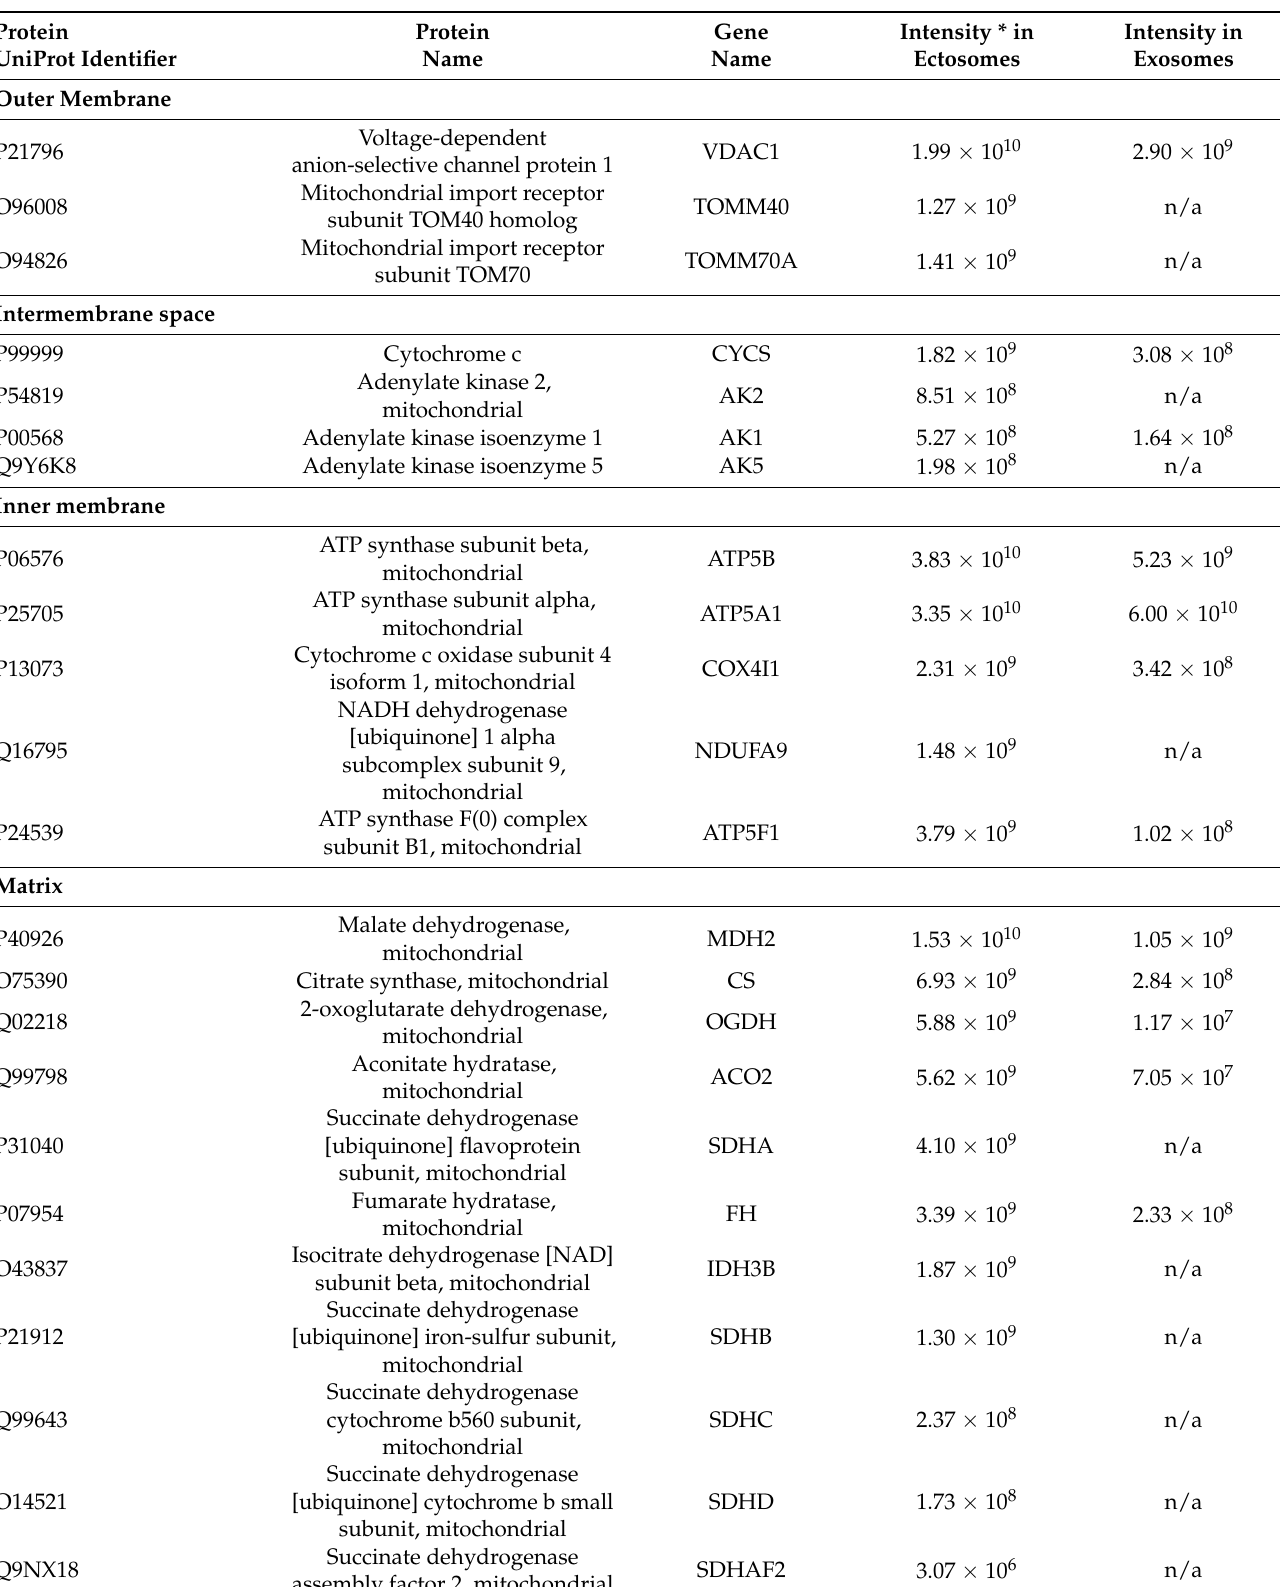
Table 2. Protein composition comparison between exo- and ectosome for proteins belonging to different mitochondria